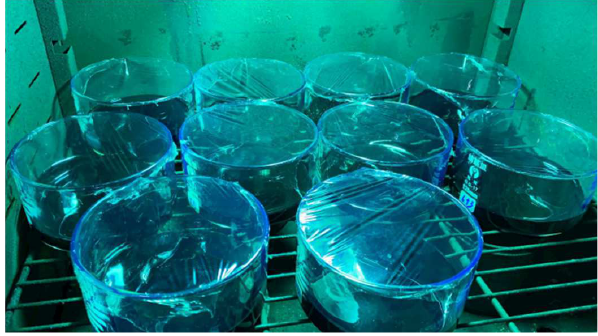
Figure 2. Self-made UV aging